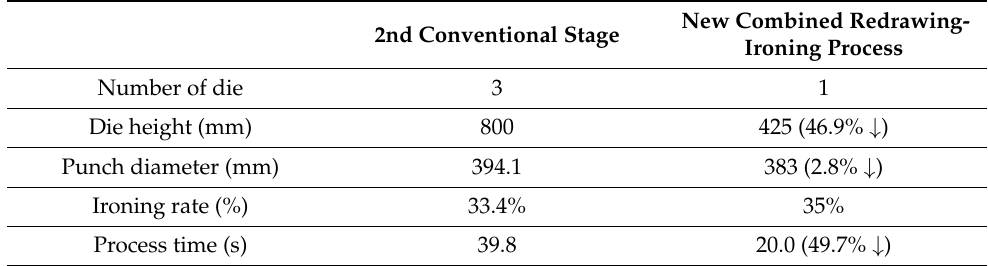
Table 6. Comparison of the new combined redrawing-ironing process with conventional 2nd